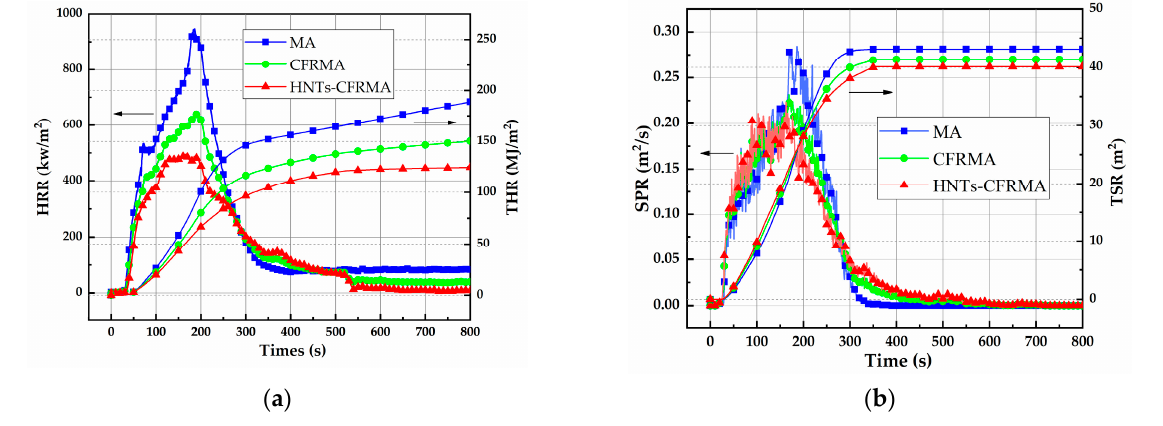
Figure 11. Characterization of flame retardant performance of flame retardant modified asphalt: ( a ) Heat release rate and total heat release; and ( b ) Smoke production rate and total smoke release.